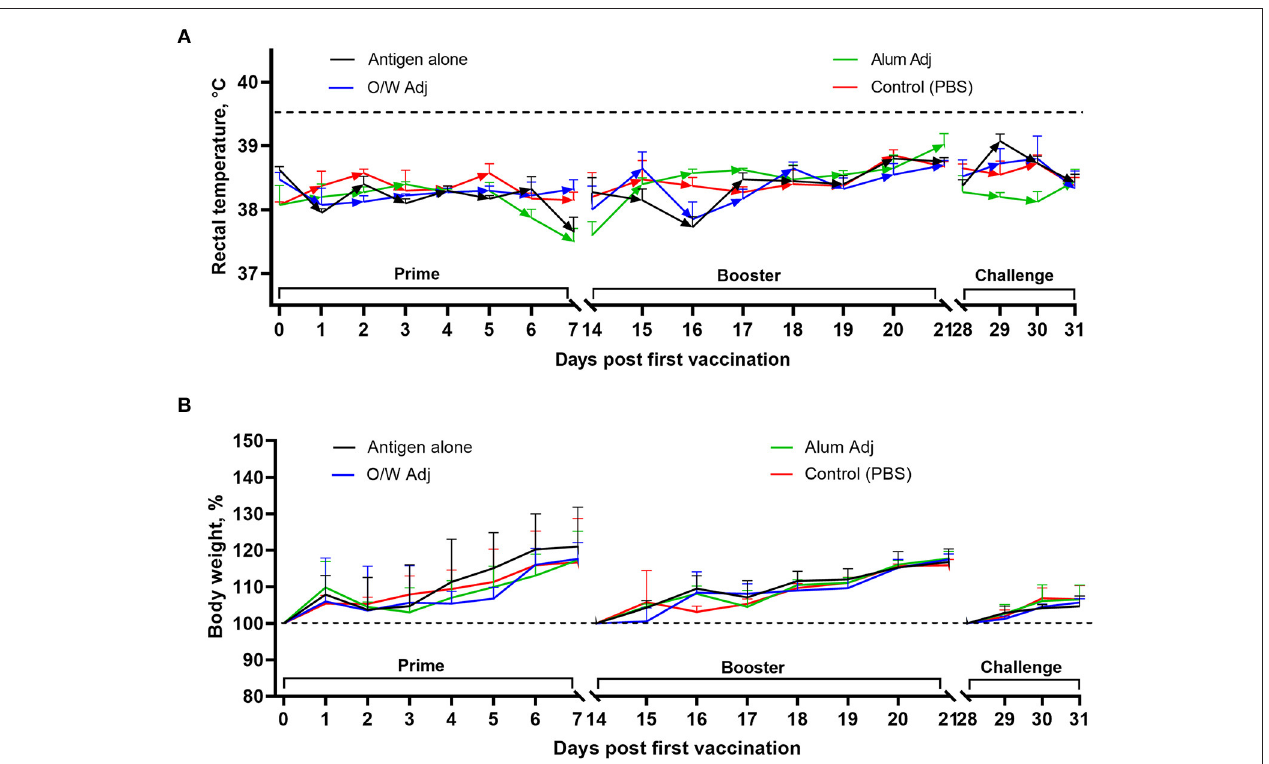
FIGURE 2 | Rectal temperature (A) and body weight (B) in juvenile cats after vaccination and challenge. Antigen was used at a dose of 5 µ g with O/W and alum adjuvants. For comparison, 5 µ g antigen was given without adjuvant and a negative PBS control. A rectal temperature ≥ 39.5 ◦ C was considered as fever (dashed line). Data shown are mean ± SEM of four juvenile cats in each